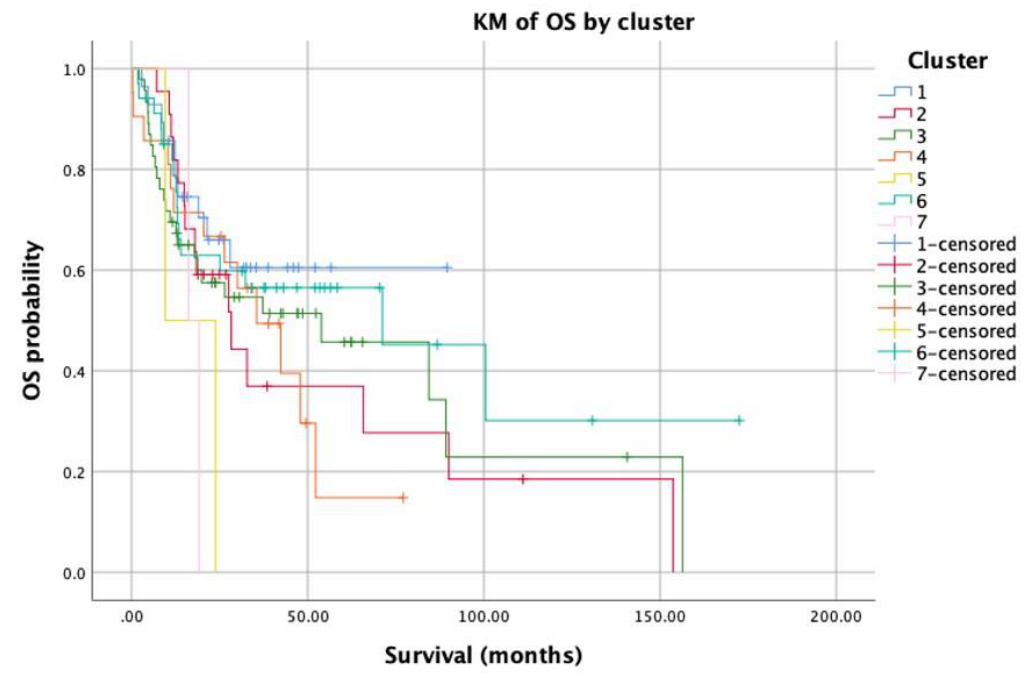
Figure 4. Kaplan-Meier analysis for overall survival of patients.